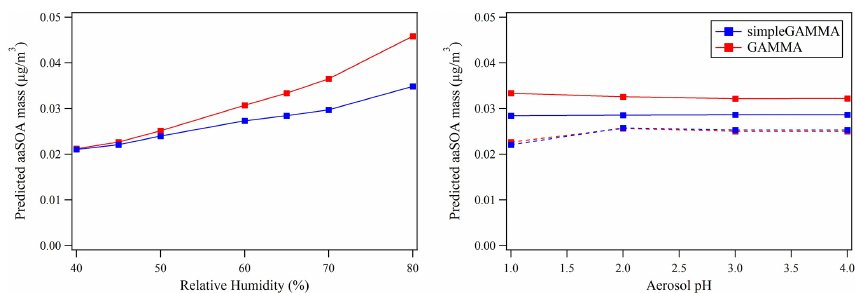
Figure 4. Comparison of predicted aaSOA after 12h of simulated time with respect to RH at pH1 (left) and with respect to pH at 45% and 65% RH (right, dotted and solid lines respectively), high-NO x